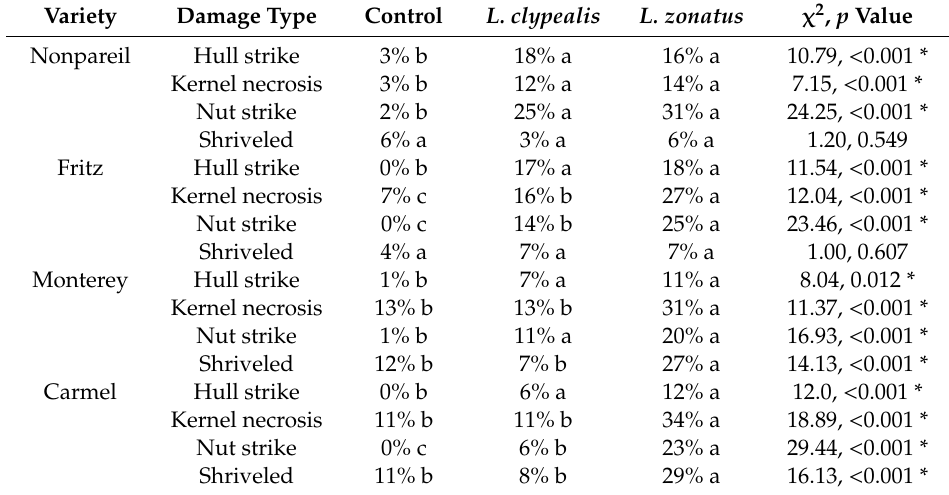
Each cell represents the percent of almonds damaged in the final sample. Chi square χ 2 goodness of fit was used to examine damage among the three treatments (in each row); an asterisk * indicates a significant di ff erence. Di ff erent letters within a row are significantly di ff erent by Fisher’s exact